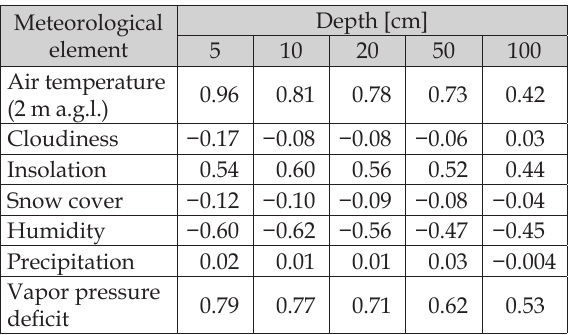
Table 11. The correlation coefficient of the soil tem- perature at particular depths and selected meteoro - logical elements in Poznań in 2011–2020.